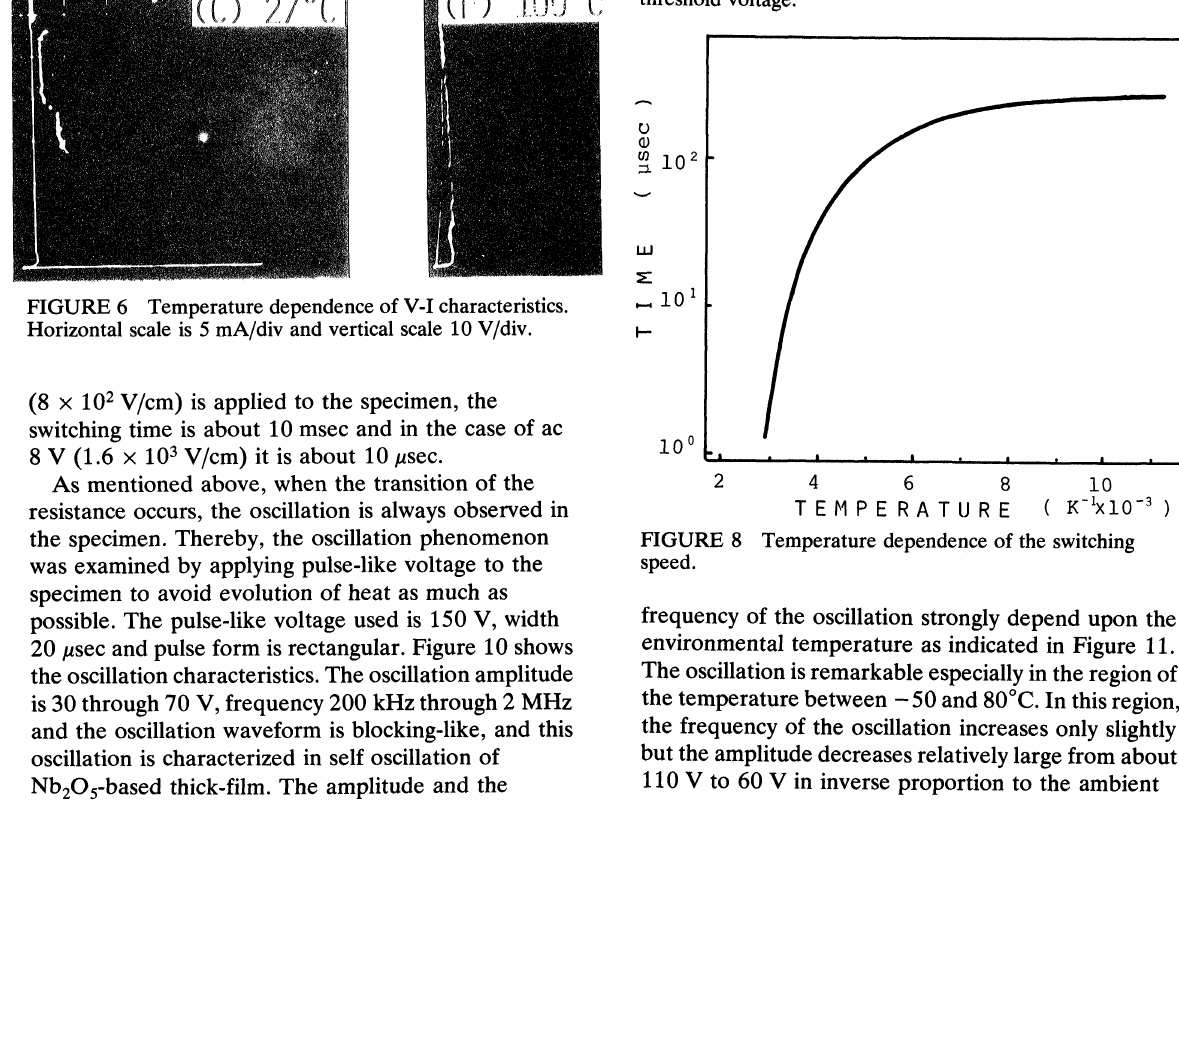
FIGURE 7 Relation between ambient temperature and threshold voltage.